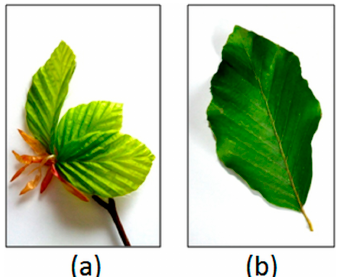
Figure 4. Difference in the beech leaves between the phenological phases of full leaf onset LO_100 ( a ) and final leaf onset (FLO) ( b ). Table 3. NDVI LAB of the samples collected on the particular DOY and the satellite-based NDVI MOD derived tor the same DOY: mean ± standard deviation, and the number of samples and values respectively, in the brackets .